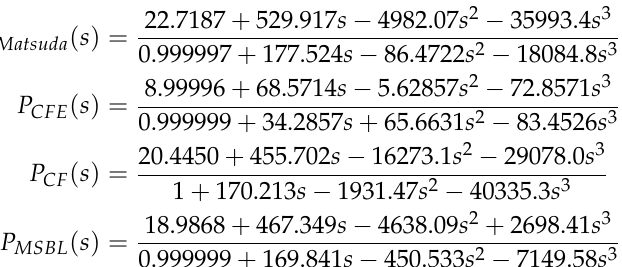
, Oustaloup’s (blue line), refined Oustaloup’s s 0.5 , Charef’s V2 (maroon line) and 1 + s 0.5 , Matsuda’s (blue line), continued fraction s 0.5